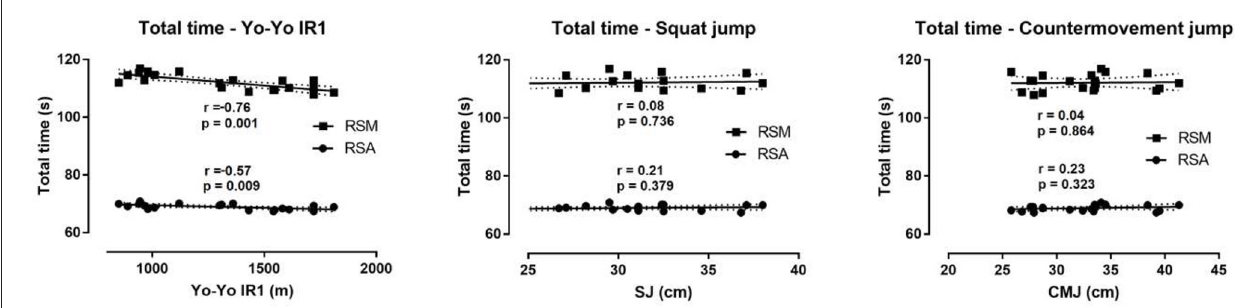
FIGURE 4 | Relationship of total time in RSM and RSA with jumping performance and aerobic capacity. SJ, squat jump; CMJ, countermovement jump; RPE, rate of perceived exertion; Yo-Yo IR1, Yo-Yo intermittent recovery test level 1; RSA, repeated sprint ability test; RSM, multi-directional repeated sprint ability